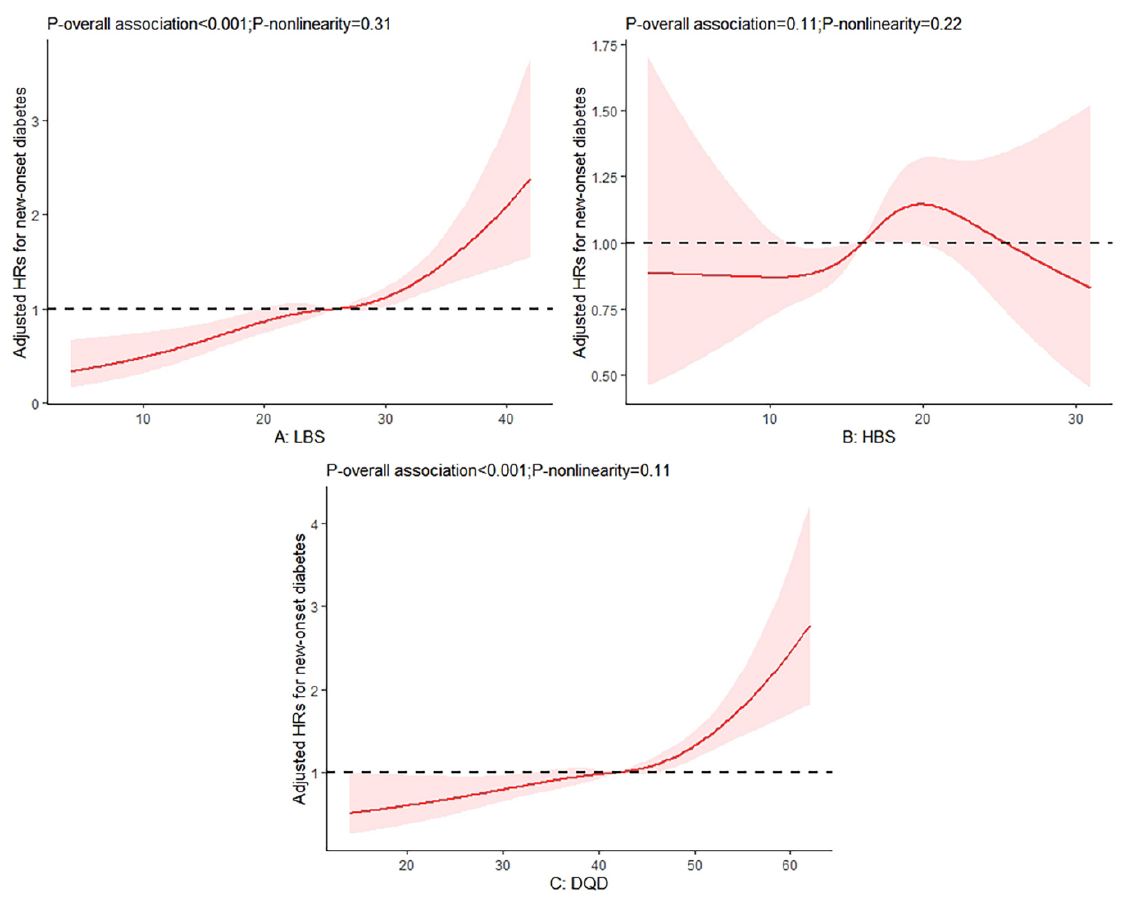
Figure 1. Relation of ( A ) the LBS, ( B ) HBS, and ( C ) DQD with the risks of diabetes. Note: Adjusted for age, sex, education level, urban or rural residence, physical activity, smoking, alcoholic drinking, body mass index (BMI), as well as hypertension.